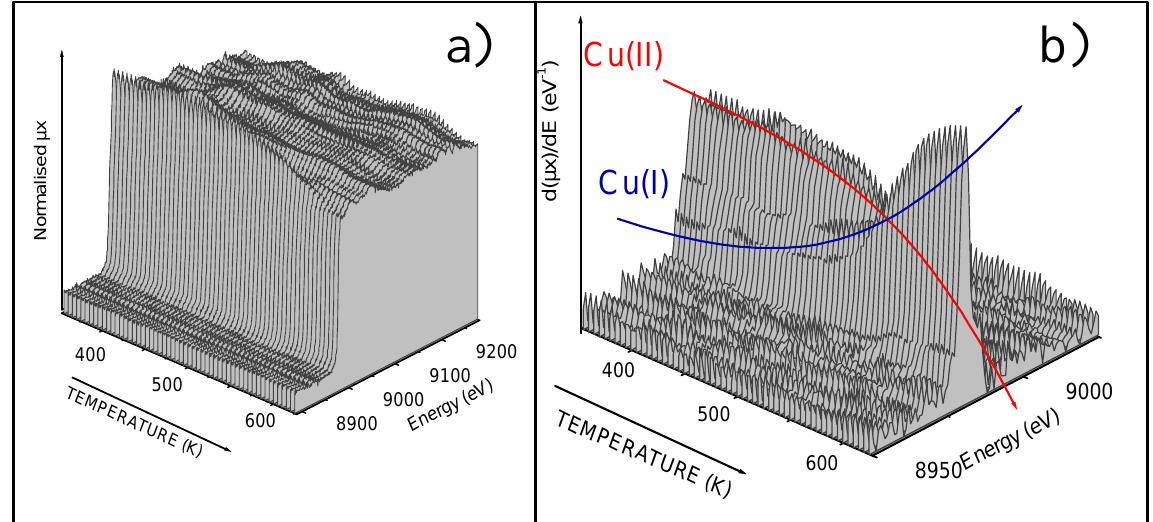
Figure 9. Time resolved X-ray absorption experiments. Part a): raw XANES spectra. Part b): corre- sponding first